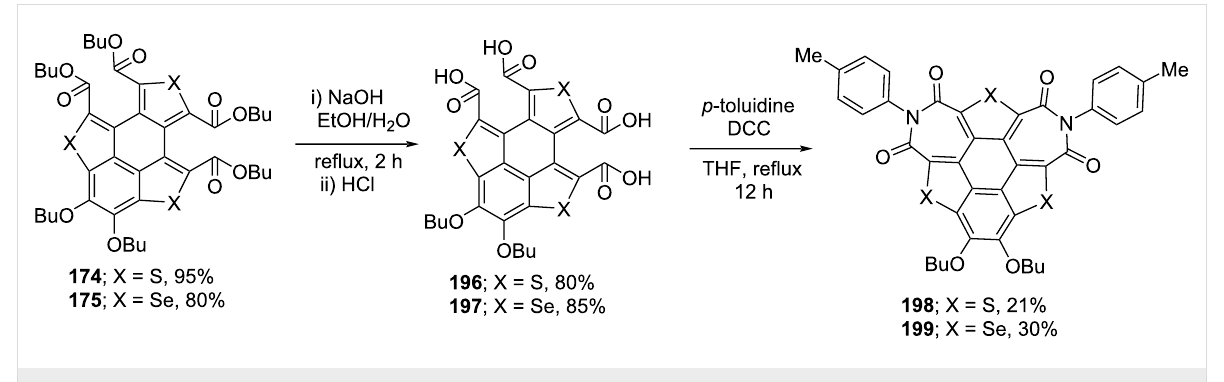
Scheme 47: Synthesis of polycyclic compounds from sumanene derivatives.